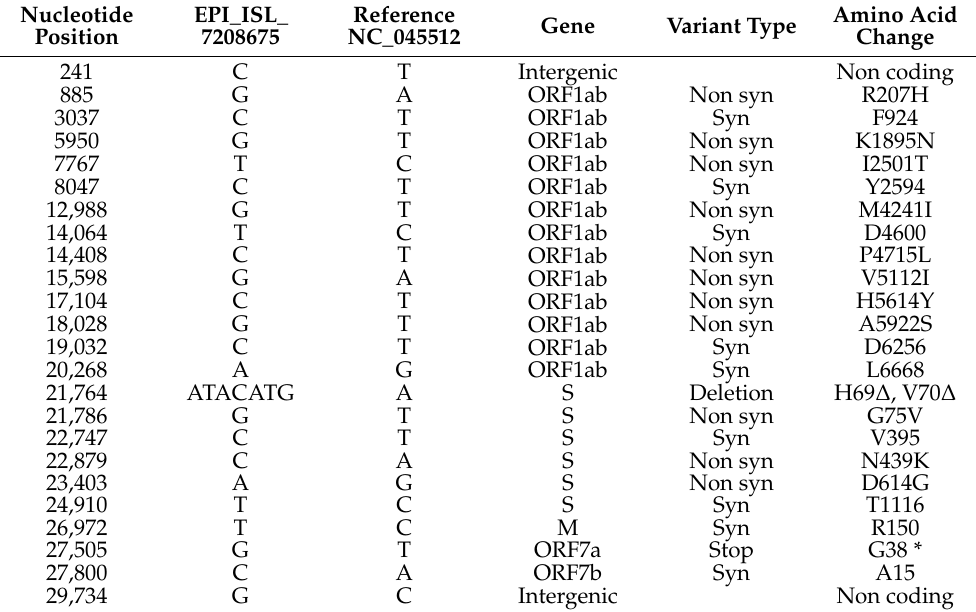
Table 4. Nucleotide mutations and amino acid substitutions in B.1.258 ( ∆ H69/ ∆ V70) (EPI_ISL_7208675) compared to the Wuhan strain (NC_045512).